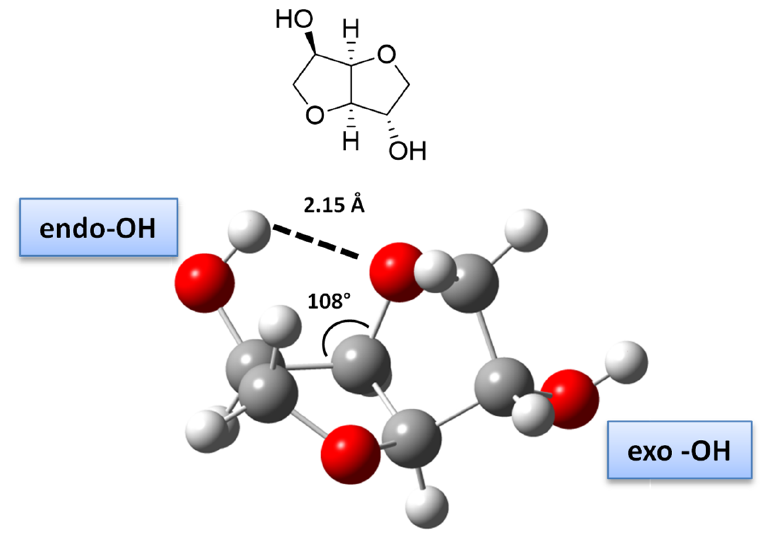
Scheme 31. The 3D structure of isosorbide with explicit intramolecular H-bonds for